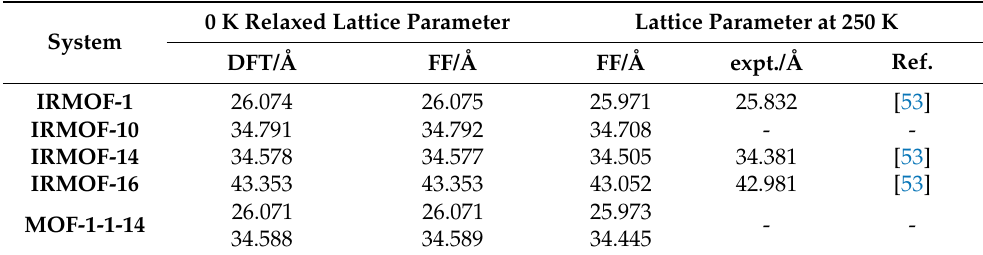
Table 1. Relaxed lattice parameters as calculated with DFT (PBE/D3BJ) and the fitted force fields. To obtain the values at 250 K, MD simulations within an NPT ensemble were performed for a simulation time of 2.5 ns. Experimental data from single-crystal XRD experiments at 258 K are listed, when avail- able. We refrained from recalculating the lattice constants for exactly these temperatures, as, based on theoretically and experimentally obtained thermal expansion coefficients for IRMOF-1 [82,84,85], a temperature difference of 8 K between experiment and simulation would only lead to deviations of approximately 0.001 to 0.004 Å. 0 K Relaxed Lattice Parameter Lattice Parameter at 250 K System DFT/Å FF/Å FF/Å expt./Å